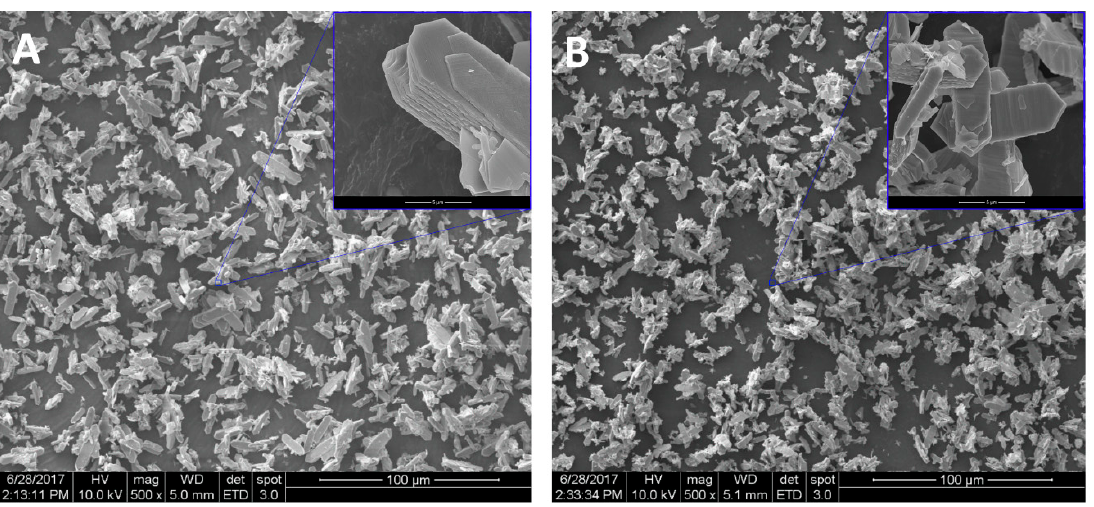
Figure 6. SEM micrographs (insets use higher magnification) of as-synthesized ( A ) and calcined ( B ) SDC20R10 samples.